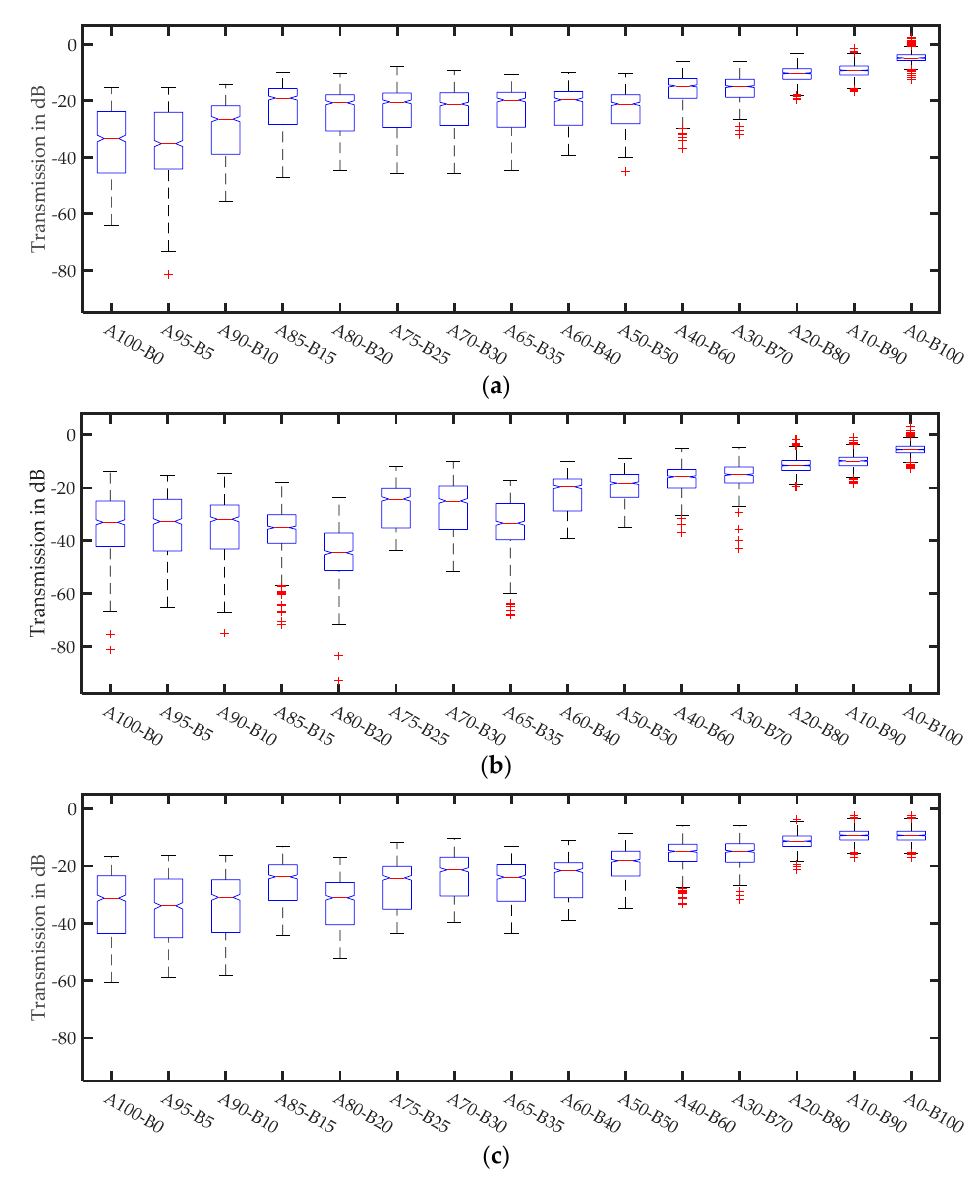
Figure 17. Averaged signal amplitudes for different mixing proportions of fractions A (0.4–0.5 mm) and B (63–100 µm): ( a ) shows the results for the Figure 15 spectra; ( b ) shows the results for the Figure 16 spectra; and ( c ) shows the averaged results of four different sample positions.